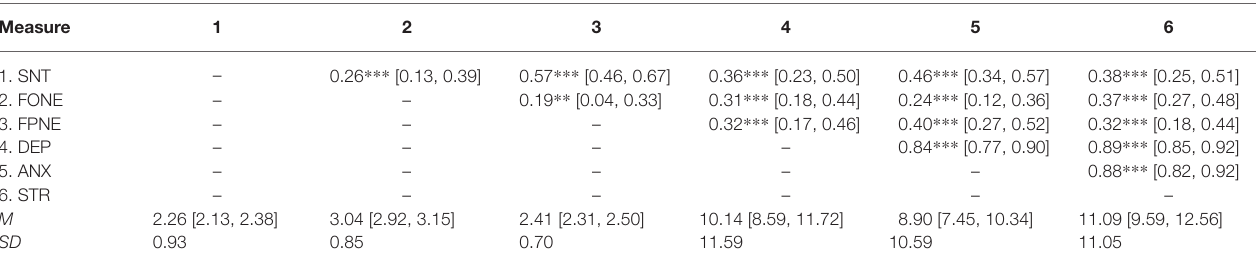
TABLE 2 | Descriptive statistics and Pearson correlations for perceptions of having transgressed a social norm (SNT), fear of own negative evaluation (FONE), fear of parental negative evaluation (FPNE), depression (DEP), anxiety (ANX), and stress (STR) for the White group, with bootstrapped 95% confidence intervals based on 10,000 bootstrap